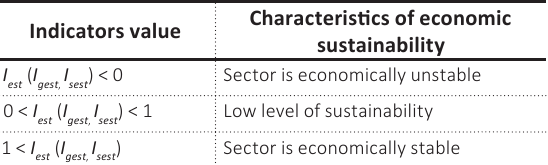
Table 1. The boundaries of indicators of economic sustainability of the transport industry